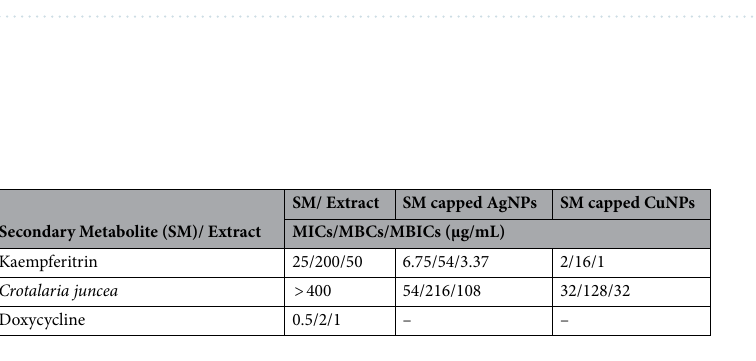
Figure 3. Physico-Chemical Characterization of Kaempferitrin AgNPs/CuNPs ( A ) UV Spectrum, ( B ) XRD, ( C ) Zeta Sizer, ( D ) TEM, ( E ) SAED, ( F ) HRTEM.